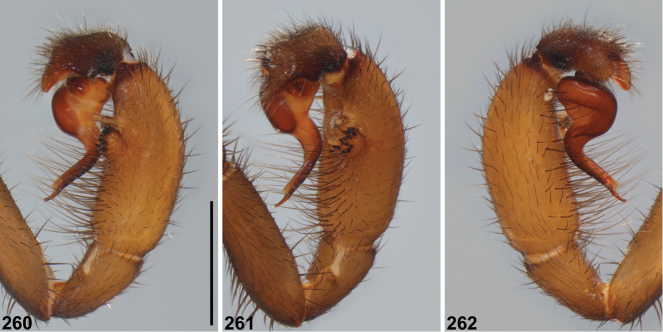

Idiosoma
kopejtkaorum sp. n., male holotype (WAM T144621) from Snake Gully Nature Reserve (Western Australia; AVW), pedipalp. 260 Retrolateral view 261 Retroventral view 262 Prolateral view. Scale bar 2.0.